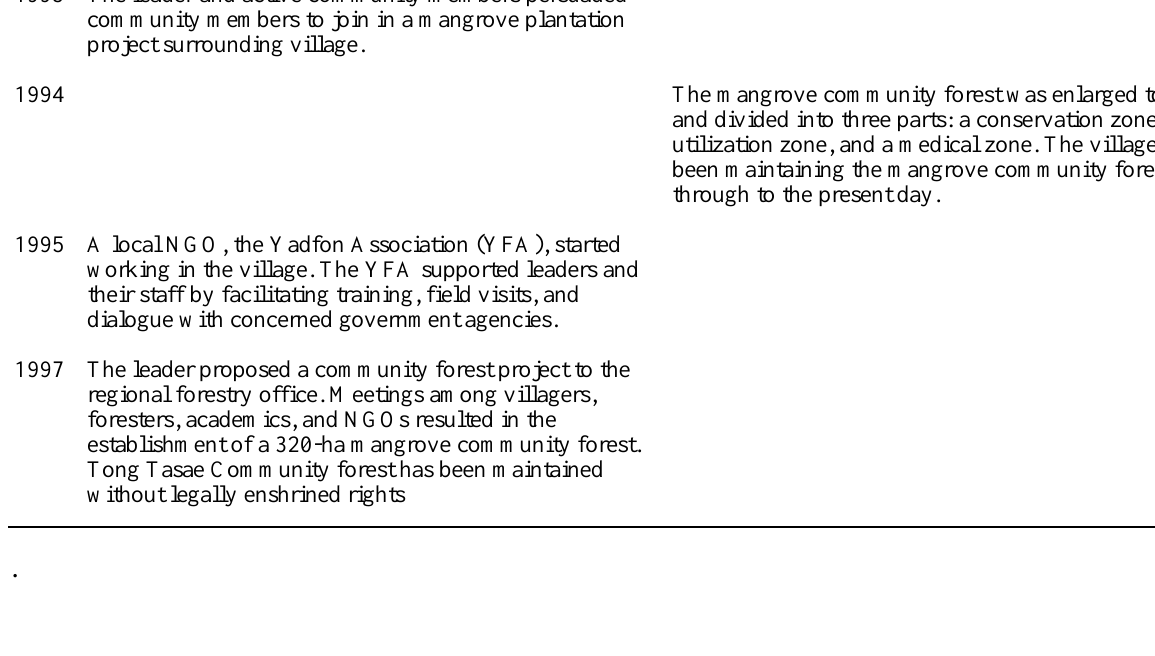
project surrounding village.